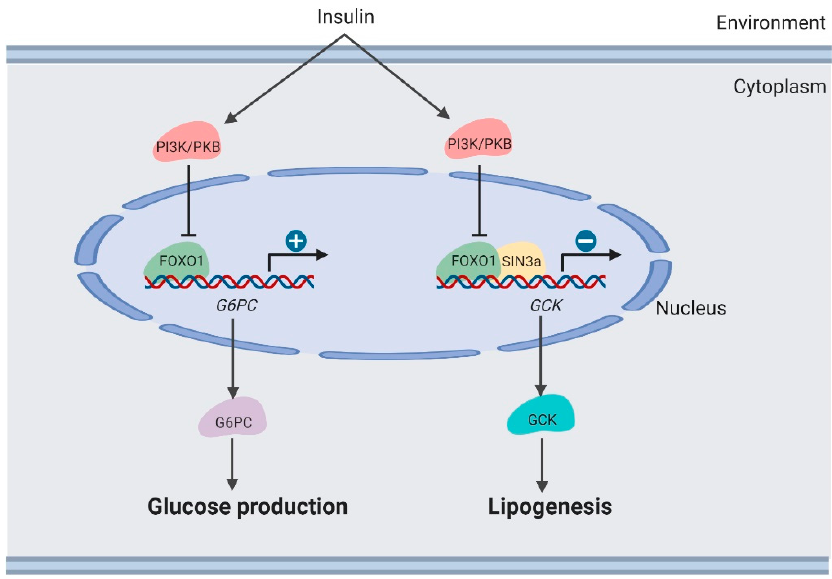
Figure 3. Regulation of lipogenesis by FOXO1 in the liver (created with BioRender.com).